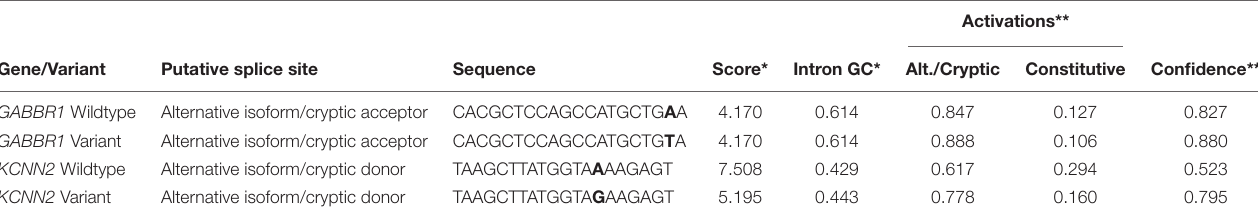
TABLE 1 | The Alternative Splice Site Predictor (ASSP) tool (Wang and Marín, 2006) determined short windows containing the loci for each of the GABBR1 and KCNN2 autism-associated